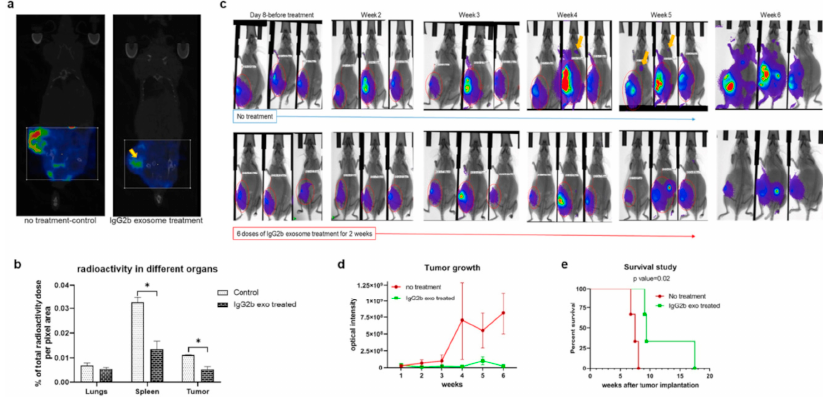
Figure 5. Treatment of 4T1 tumor-bearing animals with therapeutic engineered exosomes prevents tumor growth and metastasis and improves survival by depleting M2 macrophages. ( a , b ) Reconstructed and co-registered in vivo single photon emission computed tomography (SPECT)/CT images (coronal view) and quantification of subcutaneous syngeneic tumor-bearing animals (on the flank) injected with the 99m Tc-labeled precision peptide after 3 h. The group treated with therapeutic exosomes showed a lesser level of radioactivity in tumor (yellow arrow) and spleen compared to the untreated control group. Quantitative data are expressed in mean ± SEM, * p < 0.05; n = 3. ( c ) Optical images of 4T1 tumor-bearing animals treated with engineered therapeutic exosomes (lower panels) or without treatment (control), showing decreased tumor growth in treated animals compared to the control group. Metastatic foci in the control group were detected (yellow arrows) as early as at the fourth week from the injection, whereas no metastasis was detected in treated animals after 6 weeks. ( d ) Quantification of optical density of the tumor area also showed decreased tumor growth in treated group compared to control group. Quantitative data are expressed in mean ± SEm. n = 3. ( e ) Kaplan–Meier plot showing prolonged survival of the mice treated with therapeutic engineered exosomes.